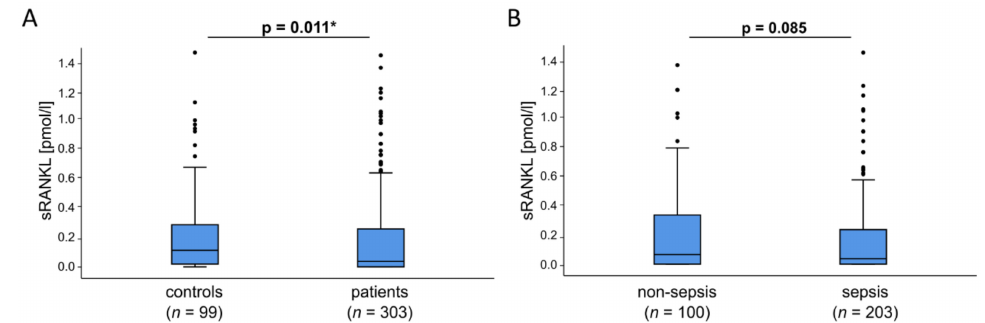
Figure 1. Serum sRANKL concentrations in critically ill patients and sepsis. ( A ) On the day of ICU admission, sRANKL serum concentrations were significantly reduced in critically ill patients compared to healthy controls ( p = 0.011). ( B ) Among critically ill patients sRANKL serum levels showed reduced levels in sepsis patients compared to non-septic patients ( p = 0.085). All data are shown as available. * p < 0.05. Table 1. Baseline patient characteristics and Soluble receptor activator of nuclear factor κ B ligand (sRANKL) plasma measurements.